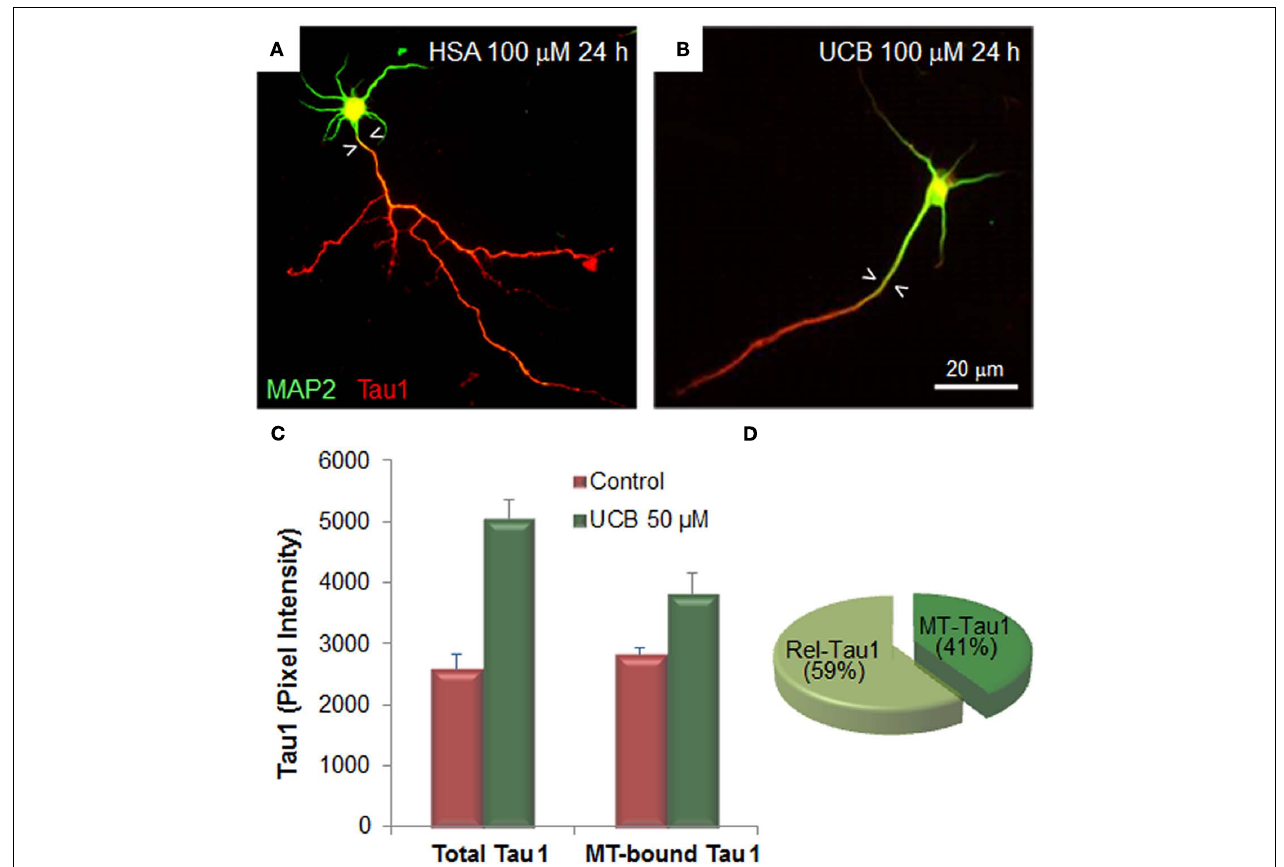
(A) for control and (B) for UCB. UCB induces MAP2 axonal entry, evidenced by the white arrowheads pointing to the portion of axon with MAP2 entry, and a decrease in the number of axonal and dendritic branches when compared with HSA alone. Graph bars representing total and MT-boundTau1 are shown in (C) illustrating that UCB induces axonal expression ofTau1. Percentage of Rel-Tau1 and MT-Tau1 in the pie chart in (D) depicts that part ofTau1 will be increasingly bound to microtubules (MT-Tau) (C,D) , although the major portion is released (Rel-Tau), as illustrated in (D) . Data derived from Fernandes et al. (2009a,